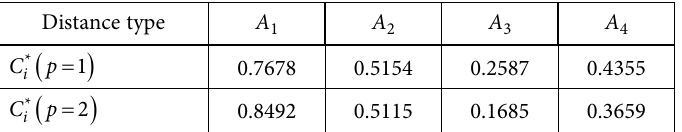
Table 18. Ranking results obtained from TOPSIS Distance type